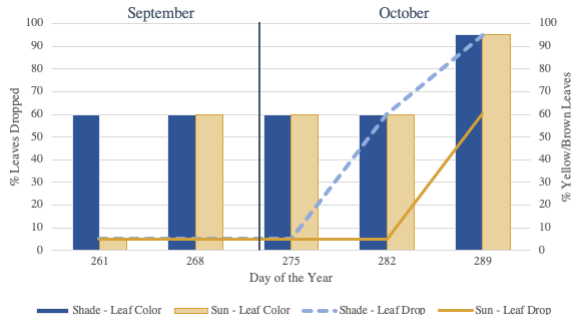
Figure 7. Temporal changes in leaf color change (lines) and leaf drop (bars) recorded in fall 2018 in the aspen trees growing in shaded (blue) and sunny (yellow) areas.